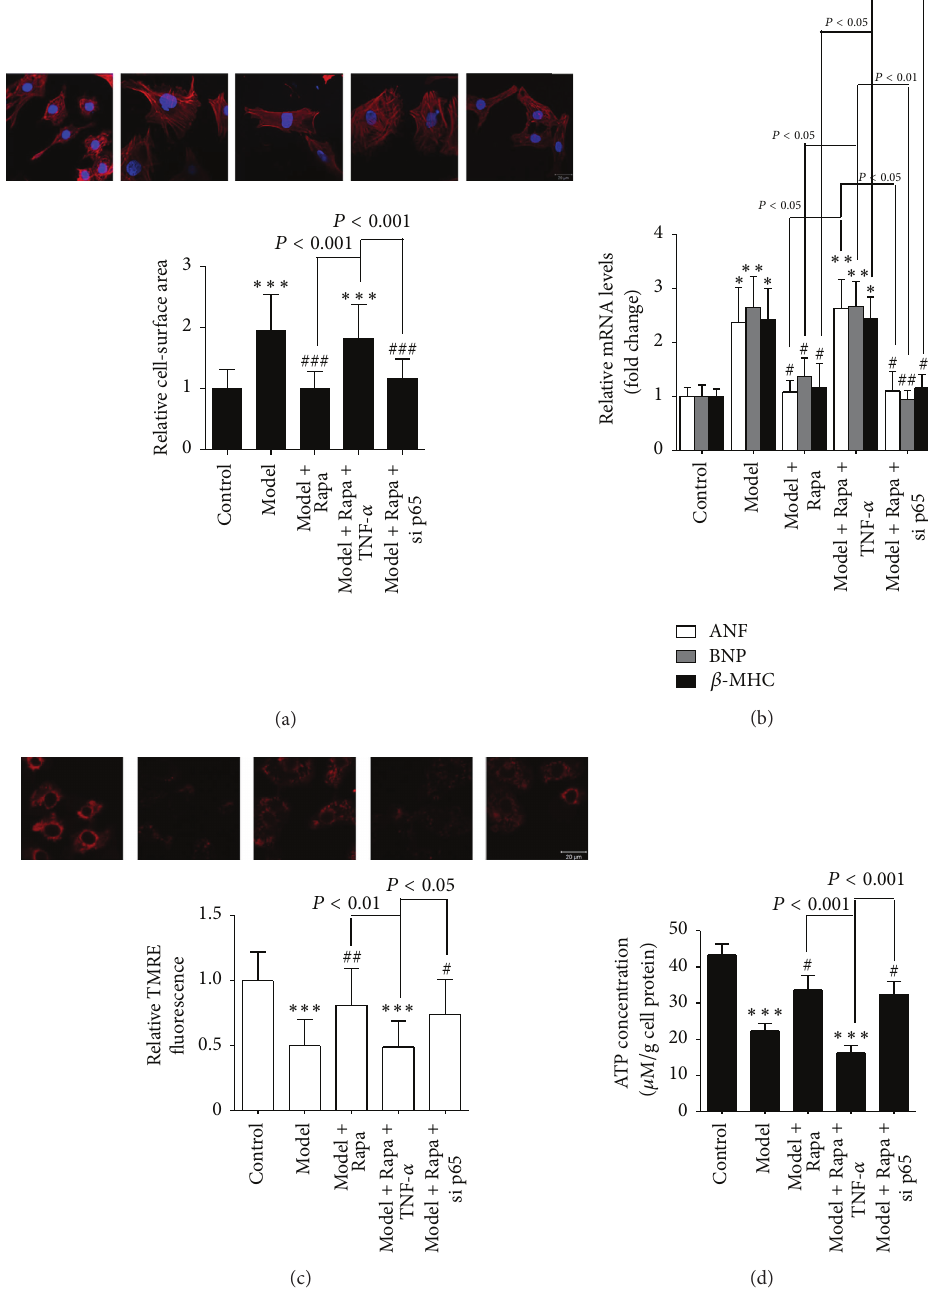
Figure 4: NF- 𝜅 B participates in the protective role of Rapa in regressing cardiac hypertrophy and energy homeostasis. (a) Cardiac myocytes were stained with rhodamine-phalloidin followed by cell surface area quantitation. (b) Gene expression pattern of atrial natriuretic factor (ANF), brain natriuretic peptide (BNP), and 𝛽 -myosin heavy chain ( 𝛽 -MHC) among different groups. The mRNA was prepared and normalized to GAPDH gene. (c) Fluorescence of mitochondrial in TMRE loaded active cardiac myocytes under different treatments. The relative values of TMRE fluorescence intensity was normalized to 1.0. Scale bar, 20 𝜇 m. The results were obtained from three independent experiments. (d) ATP production. 𝑛 = 3 experiments in duplicate. Error bars, SD. ∗ 𝑃 < 0.05 versus control group; ∗∗ 𝑃 < 0.01 versus control group; ∗∗∗ 𝑃 < 0.001 versus control group; # 𝑃 < 0.05 versus model group; ## 𝑃 < 0.01 versus model group; and ### 𝑃 < 0.001 versus model